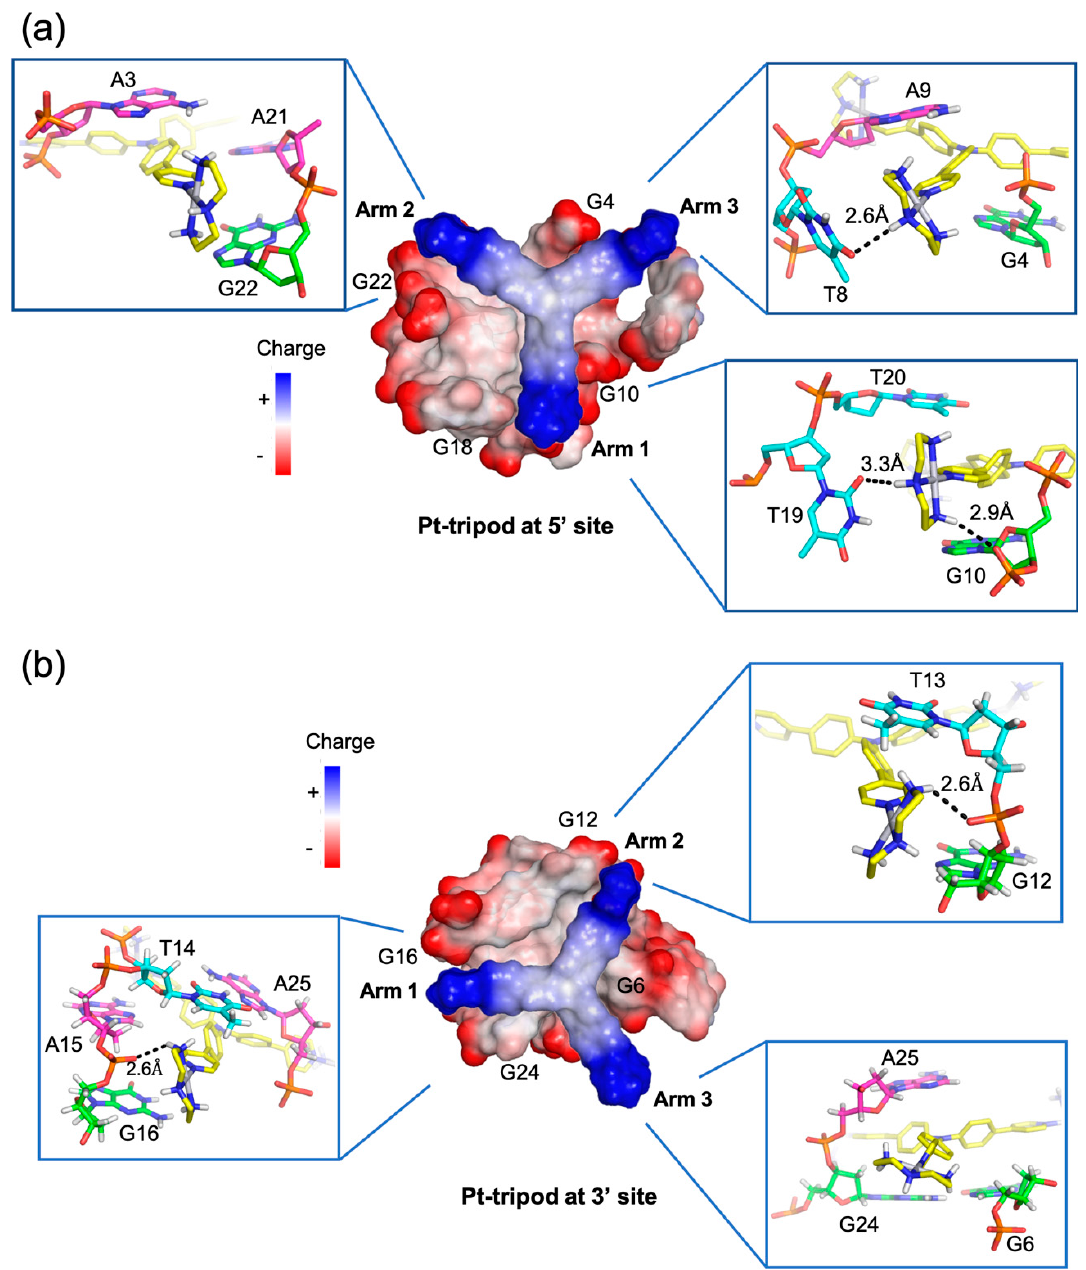
Figure 7. Arm-groove interactions of Pt-tripod at 5 ′ and 3 ′ sites in the 4:2 Pt-tripod/hybrid-1 complex. ( a ) Top view of Pt-tripod at the 5 ′ site of hybrid-1 without capping structure (middle). The binding pocket surface is color coded according to the charge. The interaction details between each arm and groove are shown in enlarged view (corners). ( b ) The same information is shown for Pt-tripod at the 3 ′ site. Potential hydrogen bonds are shown in black dashed lines.